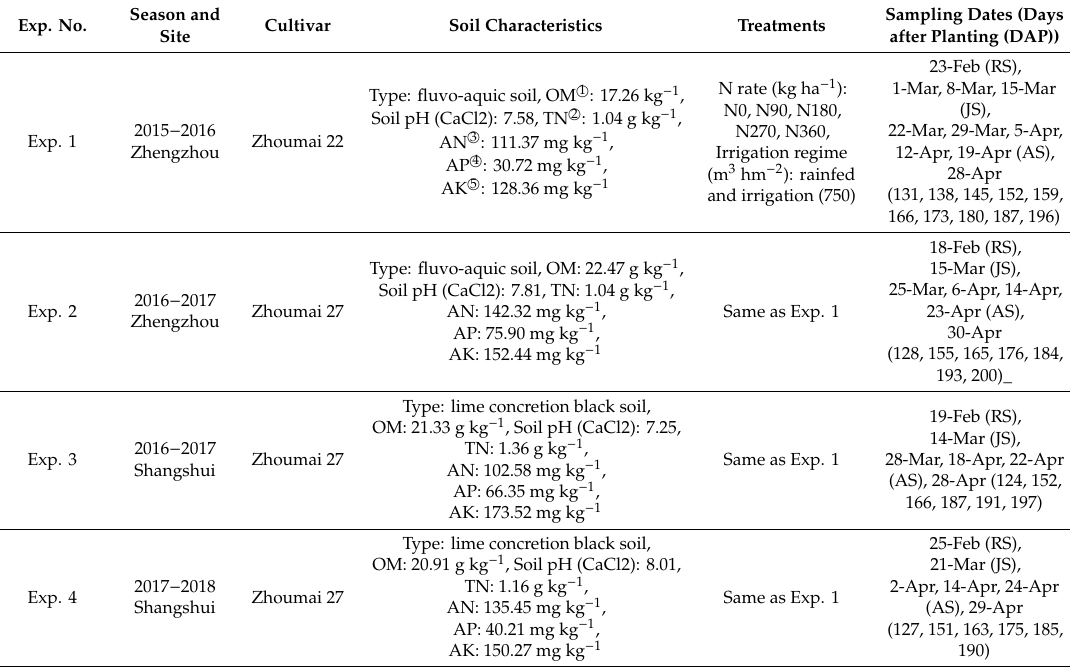
Table 1. The experimental conditions, N fertilizer levels, irrigation regimes, and sampling date. Exp. No. Soil